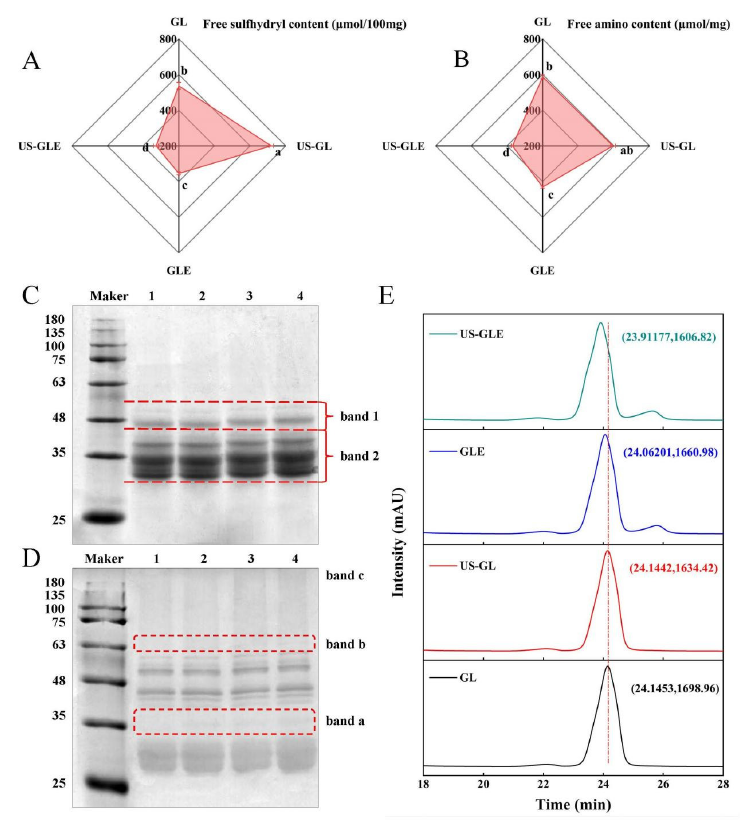
Figure 1. Free -SH ( A ), free -NH 2 ( B ), SDS-PAGE ( C ), non-reducing SDS-PAGE ( D ) and HP-LC ( E ) analysis of GL, US-GL, GLE, and US-GLE. The electrophoretic bands of GL, US-GL, GLE, and US-GLE are shown in lanes 1–4 in ( C ) and ( D ), respectively. x and y in ( E ) indicate HP-LC peak retention time of the sample and UV absorption peak intensity, respectively. Values with different letters (a–d) in the figure indicate significant differences ( p <